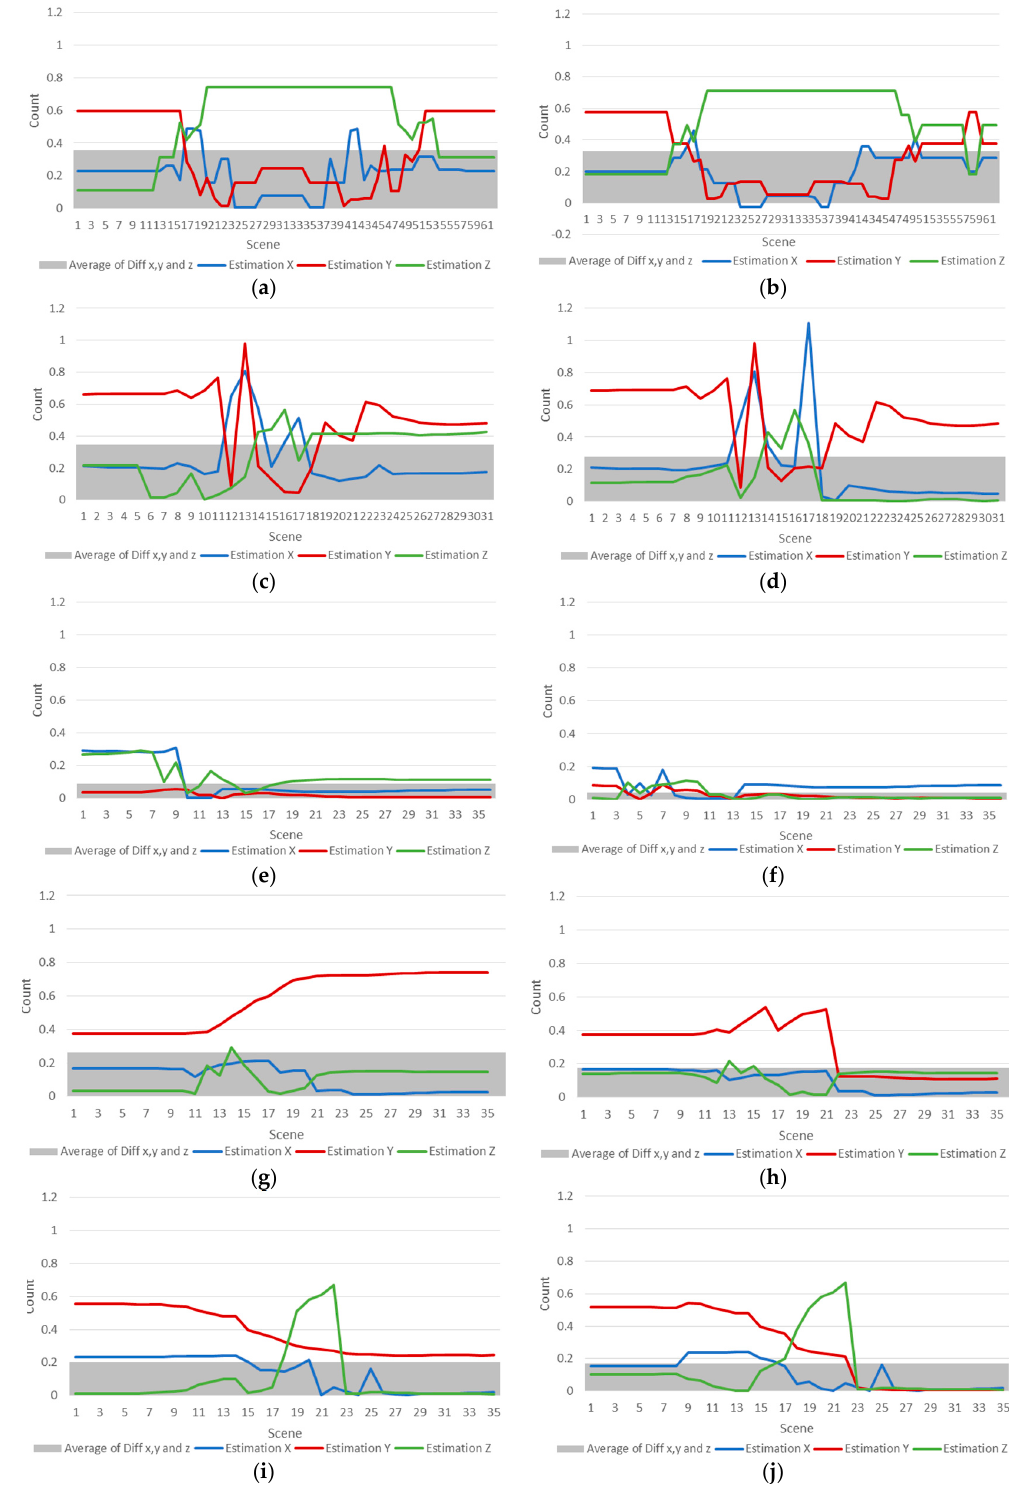
Figure 12. Differences in EMG estimation between the traditional method [17] and the proposed method, and the average of the cumulative x, y, and z error. ( a , c , e , g , i ) compare the differences in the estimated motion of the x, y, and z EMG using the previous research method. ( b , d , f , h , j ) show the EMG based motion estimation results using Bayesian probability that reflects the weights calculated by the genetic